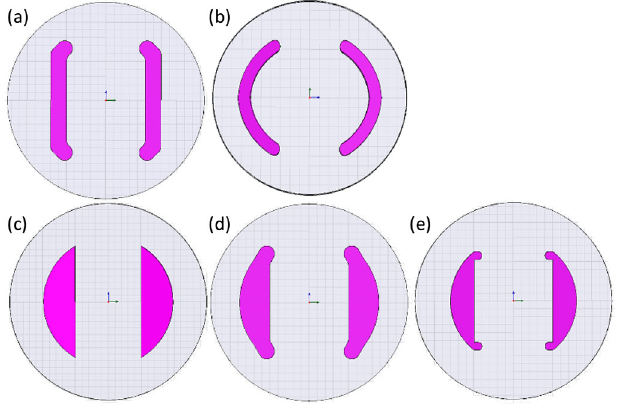
FIG. 4. Electrode shapes studied: flat electrodes (a), curved electrodes (b), and half-moon electrodes (c) –